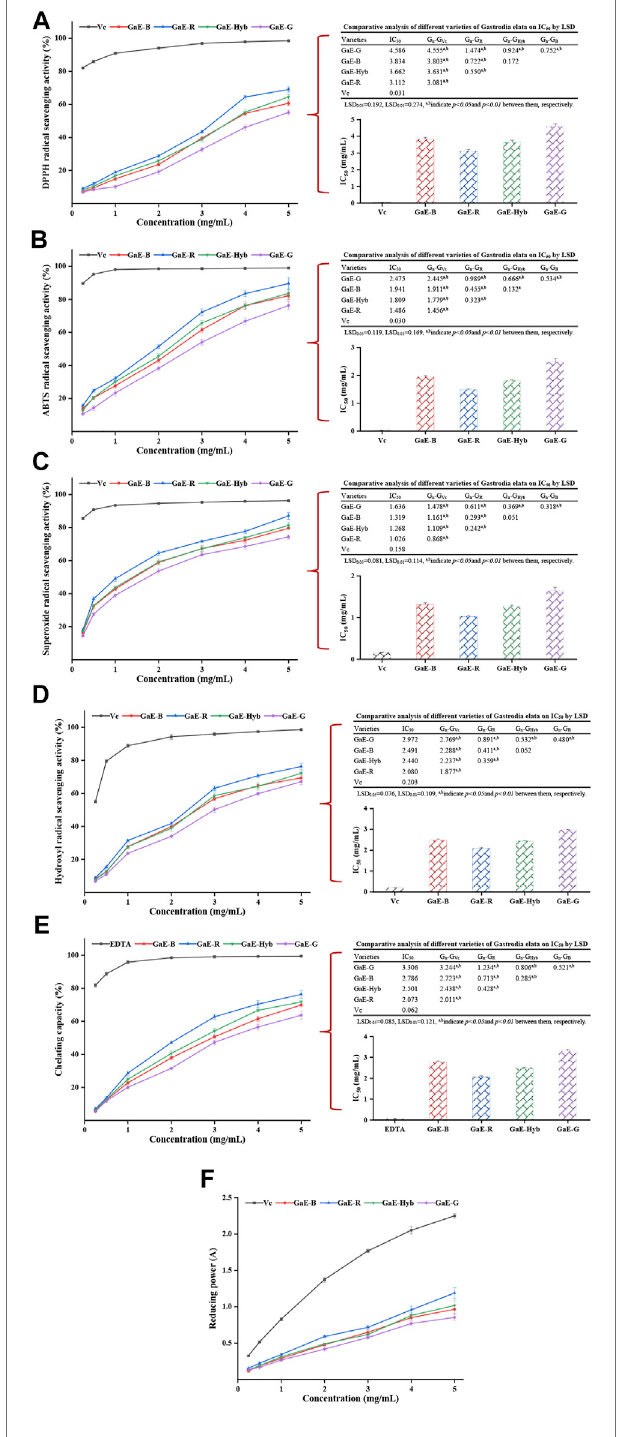
FIGURE 7 | Antioxidant activities of the different varieties of Gastrodia elata polysaccharides at different concentrations in vitro and IC 50 values: (A) DPPH radical scavenging activity and IC 50 values; (B) ABTS radical scavenging activity and IC 50 values; (C) superoxide radical scavenging activity and IC 50 values; (D) hydroxyl radical scavenging activity and IC 50 values; (E) chelating activity on ferrous ion and IC 50 values; and (F) reducing power. The respective value is expressed as the means ± standard deviation (SD) of triplicate